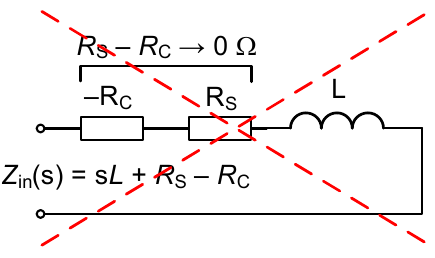
Figure 1. The easiest method for the cancellation of serial resistance of the inductor, inapplicable in linear applications.